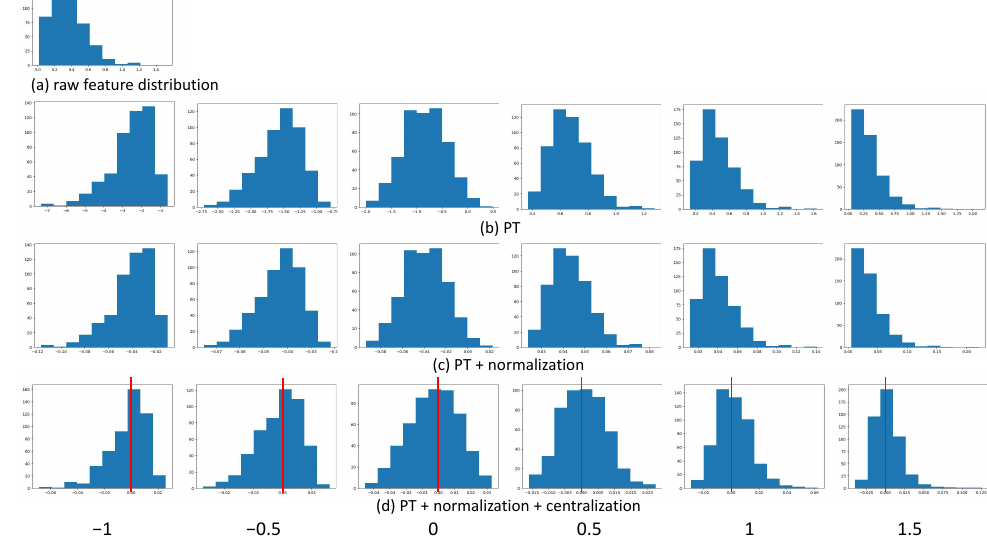
Figure 3. The histograms of different β of each step in the GC module. The red line highlights the symmetry of the histogram when µ = 0. ( a )The raw feature distribution. ( b ) After PT. ( c ) After PT + normalization. ( d ) After PT + normalization +